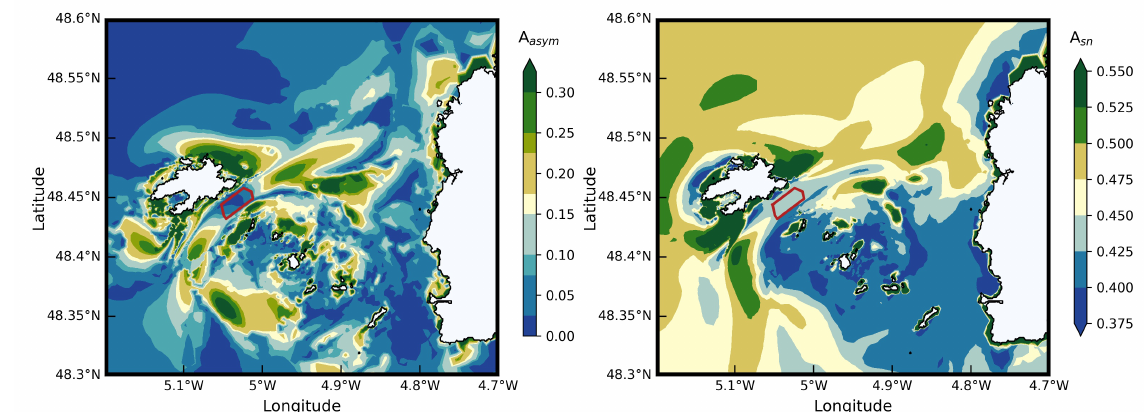
Figure 6. Spatial distribution of parameters ( left ) A asym and ( right ) A sn in the Ushant-Molène archipelago. The red line delimits the area of interest for the implementation of turbines within the Fromveur